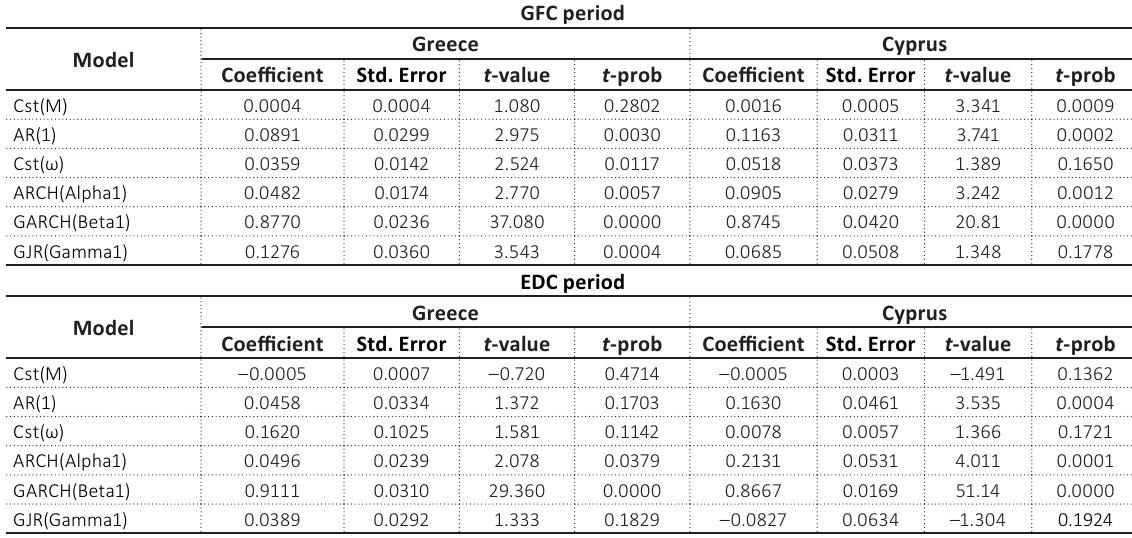
Table 2. Univariate estimations AR(1) – GJR GARCH (1,1)